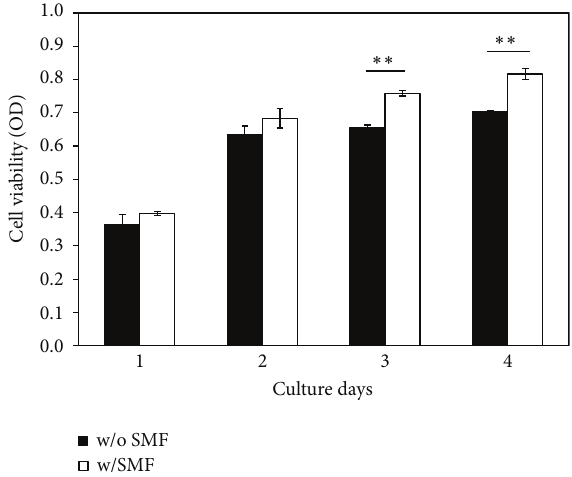
Figure 6: DPC cell grown after prolonged culturing in an SMF environmentwasenhanced.CellviabilityoftheSMF-exposedgroup was significantly higher than the sham-exposed group (𝑃 < 0.001) at day 3 and day 4.